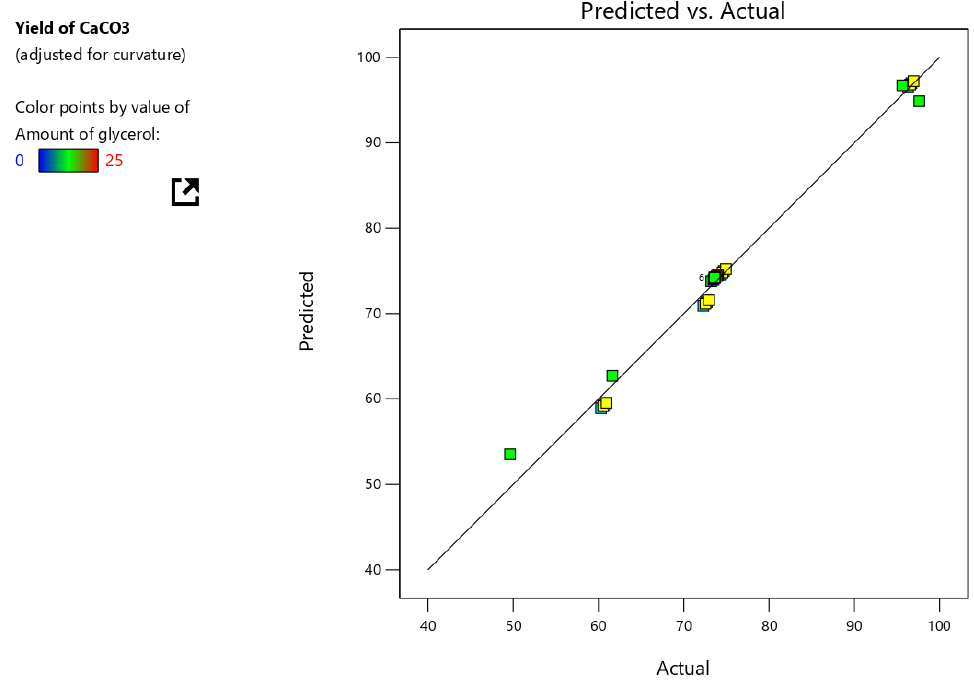
Figure 10. CaCO 3 yield relationship between expected and experimental results .